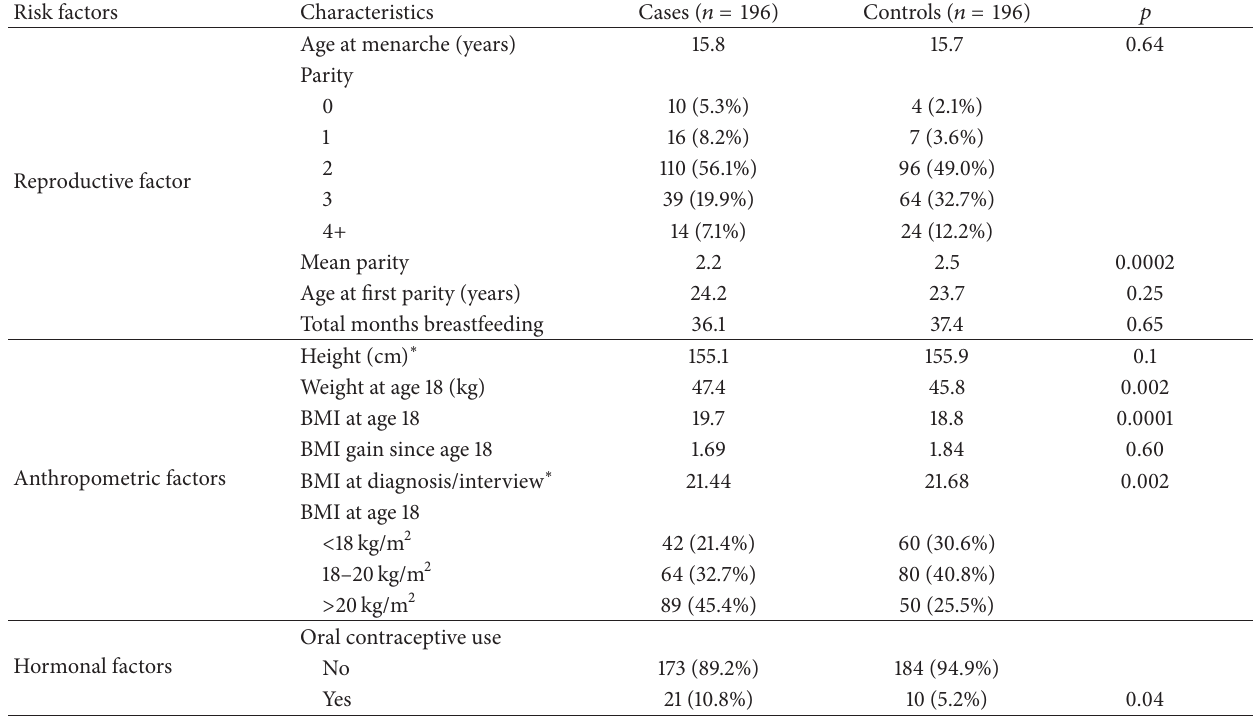
Table 4: Characteristics of breast cancer cases and matched controls for premenopausal